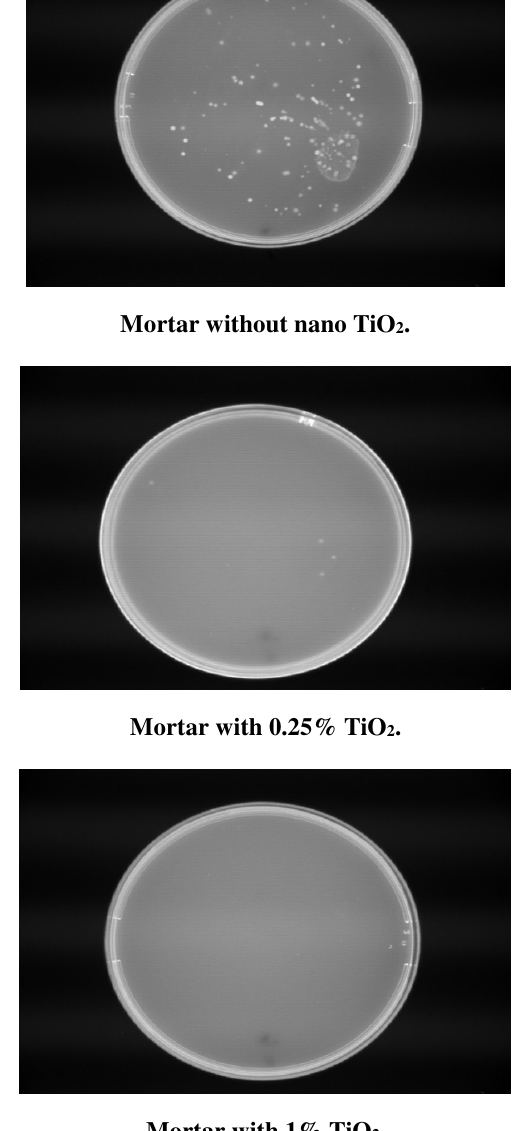
Fig. 5. Effect of anti-bacteria on